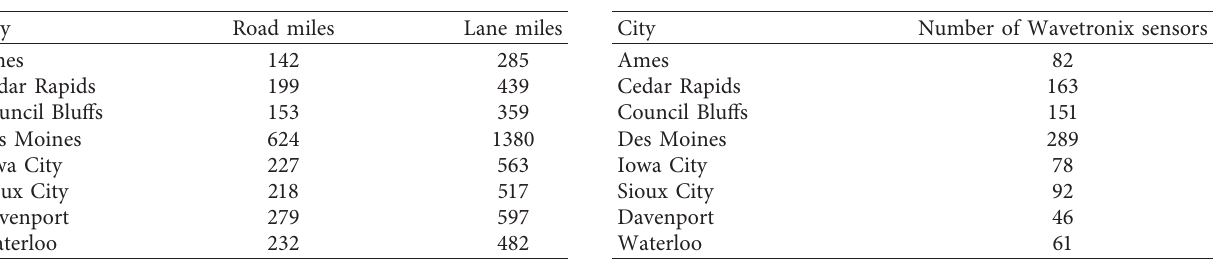
Table 2: Roadway miles breakdown by city. Table 3: Number of Wavetronix sensors in each